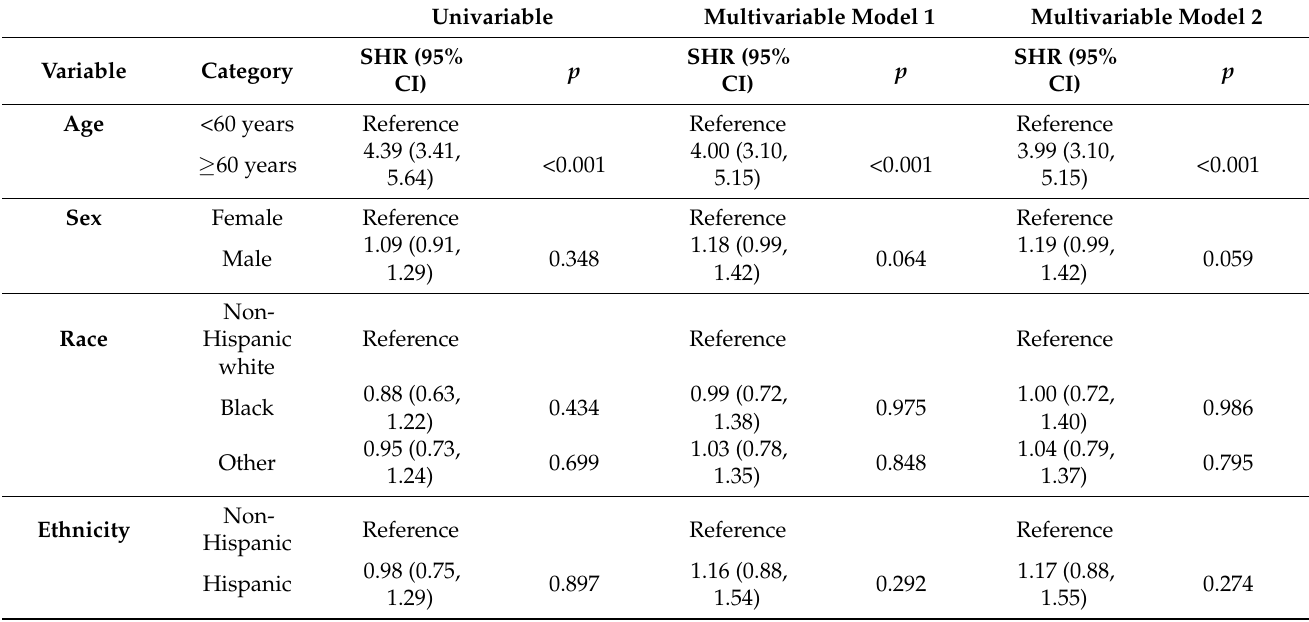
Table 4. Fine–Gray models for lymphoma-specific survival in stage I EMZL cohort. (N = 7961, including 515 deaths from lymphoma and 1558 deaths from other causes as competing